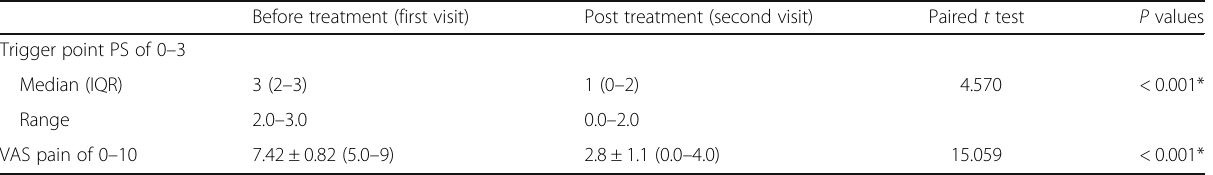
Table 2 Before and after treatment values in the lidocaine injection group. Values are median (IQR) and range for PS pain score and mean ± SD and range for (VAS) visual analog